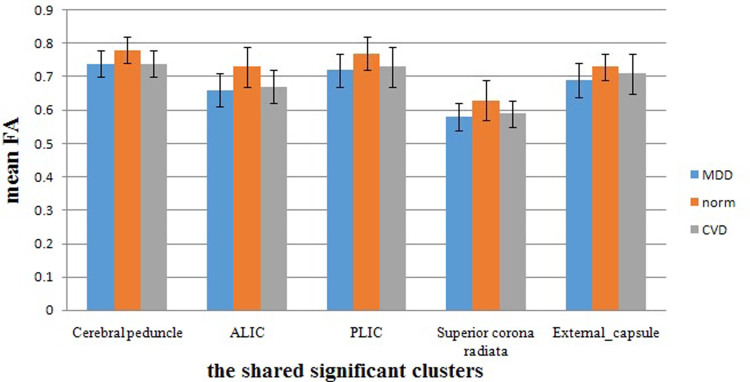
The mean FA values across the MDD, CVD and healthy control groups for shared significant clusters in the TBSS.